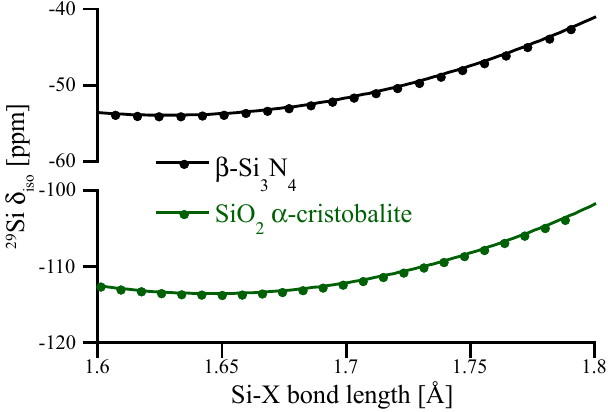
Figure 4. Correlation between average Si-O or Si-N bond lengths and 29 Si NMR chemical shifts. The y -axis has been adjusted to allow better comparison between the curves. The correlations are obtained by the scaling of SiO 2 α -cristobalite and β -Si 3 N 4 models, respectively. The bond length dependence of 29 Si NMR chemical shifts appears significantly more pronounced for six-fold coordinated Si [6] . In Figure 5a we plot δ iso for Si [6] in (hypothetical) crystalline models as a function of the average Si-N bond length around that site. The graph includes data for the octahedral Si [6] site in spinel-type γ -Si 3 N 4 obtained by scaling the structure. Due to its location at a high-symmetry position, the Si [6] site in spinel-type γ -Si 3 N 4 exhibits six equal Si-N bonds.